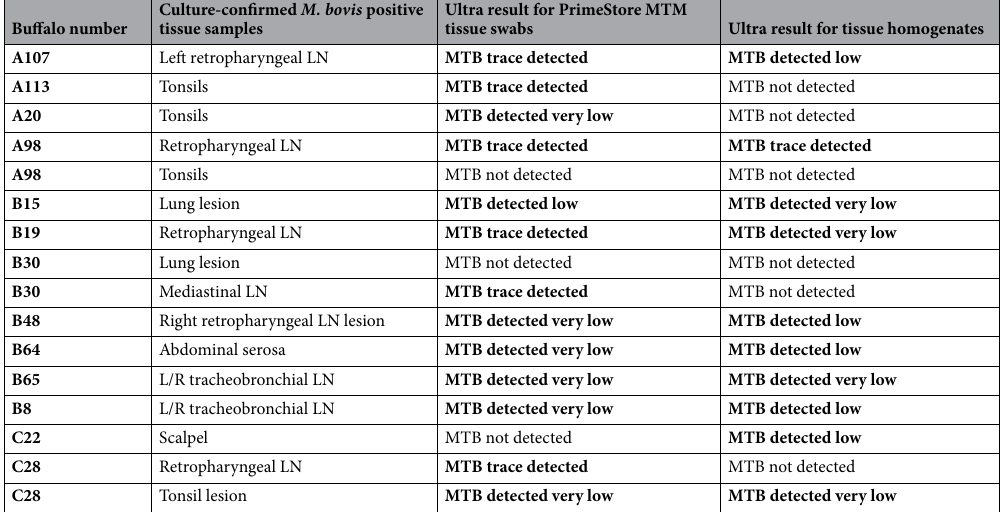
Table 1. Ultra assay results from PrimeStore MTM tissue swab samples and tissue homogenates from culture- confirmed M. bovis positive African buffaloes (n = 13). Positive results are shown in bold. Ultra—Xpert MTB/ RIF Ultra; LN—Lymph node; L/R—Left and right ; MTM—molecular transport